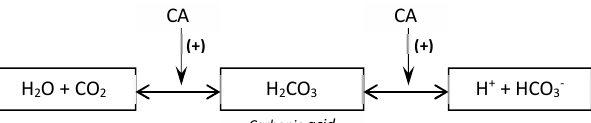
Figure 2: The carbonic acid/bicarbonate buffer system ( CA: carbonic anhydrase)